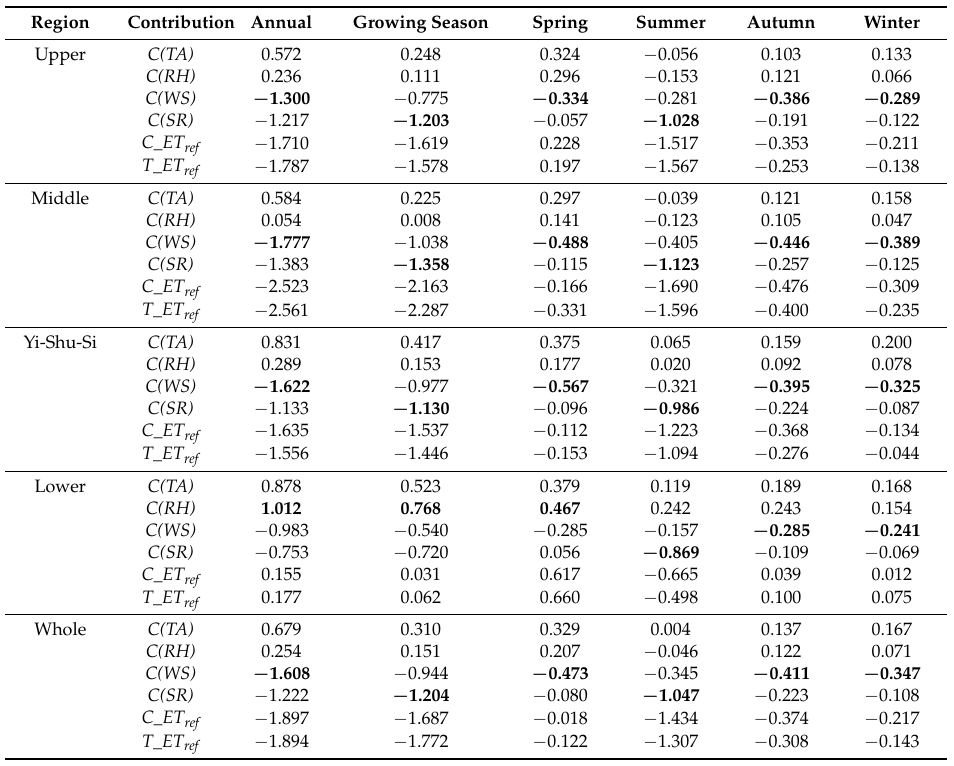
Table 4. Annual and seasonal contributions (mm · a − 2 ) of the main climate factors to ET ref in each region of the HRB during